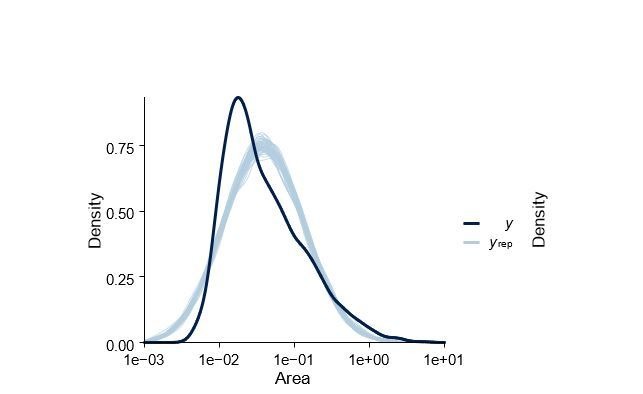
Posterior predictive check of statistical model shown in Figure 5—figure supplementary 1.Dark blue density labelled y is the real data and lighter blue lines labelled yrep are datasets simulated from the posterior.